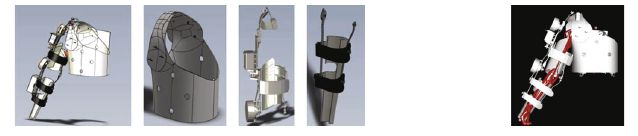
Figure 9: Wearable device model components and their position and orientation in the model. The modeled components shown in (a) were designed using the CAD Creo Software and later been imported into the OpenSim software to produce a human-device integrated model (b) that will later be used in simulation in the OpenSim